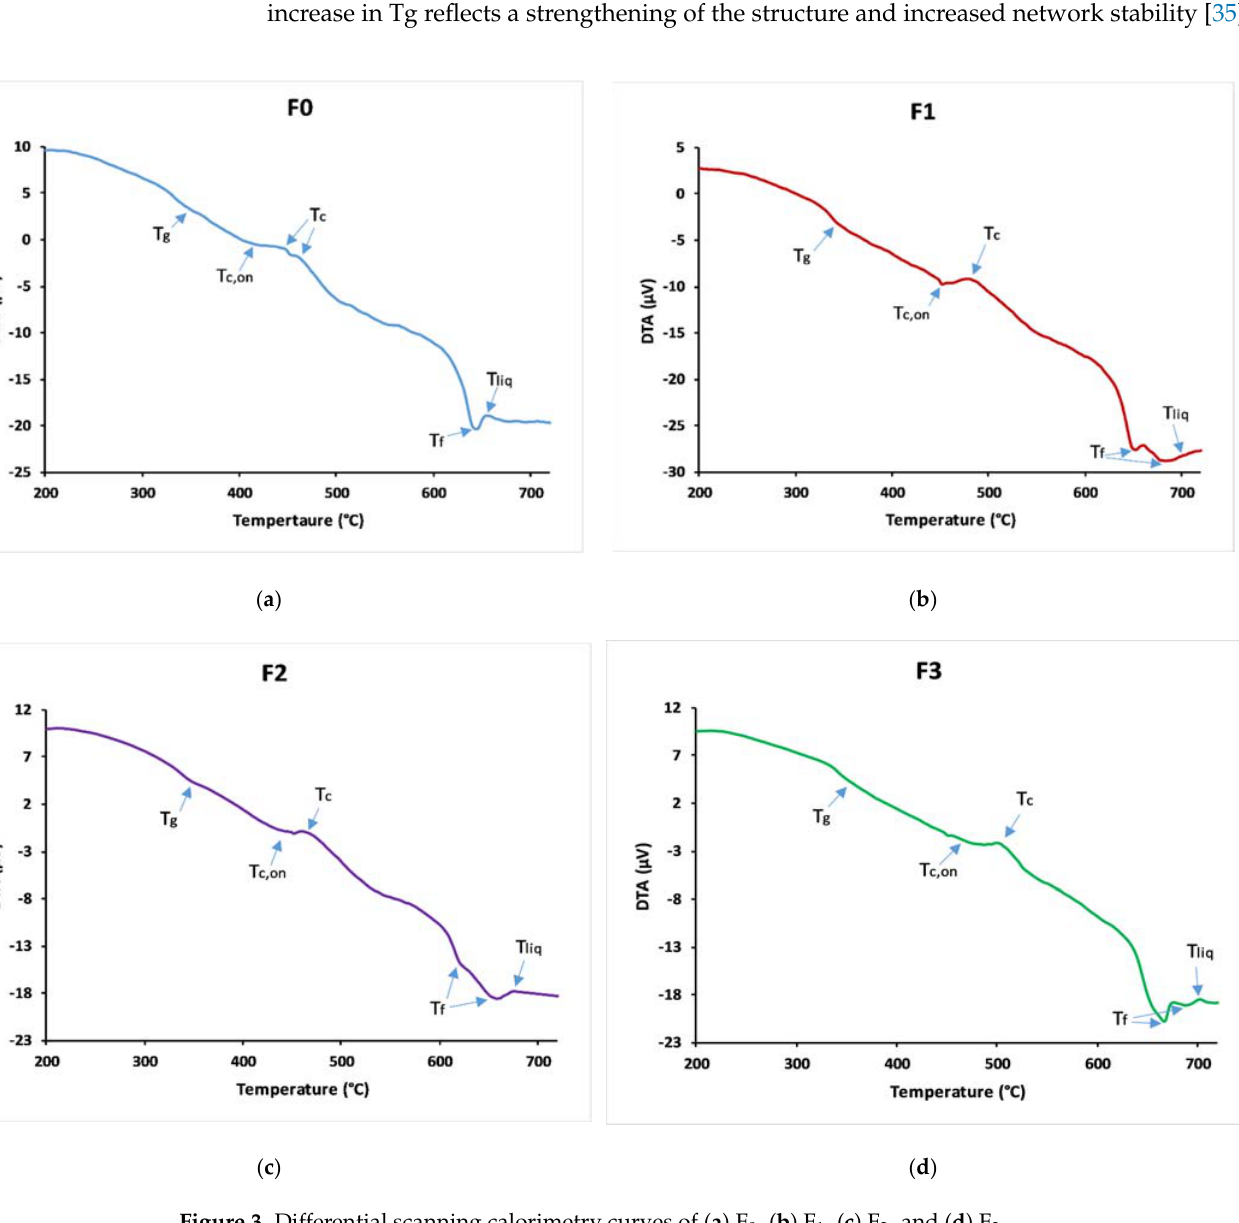
Figure 3. Differential scanning calorimetry curves of ( a ) F 0 , ( b ) F 1 , ( c ) F 2 , and ( d ) F 3 . Table 2. Glass transition (T g ) crystallization (T c,on ) melting (T liq ) temperatures and K H of prepared glasses.